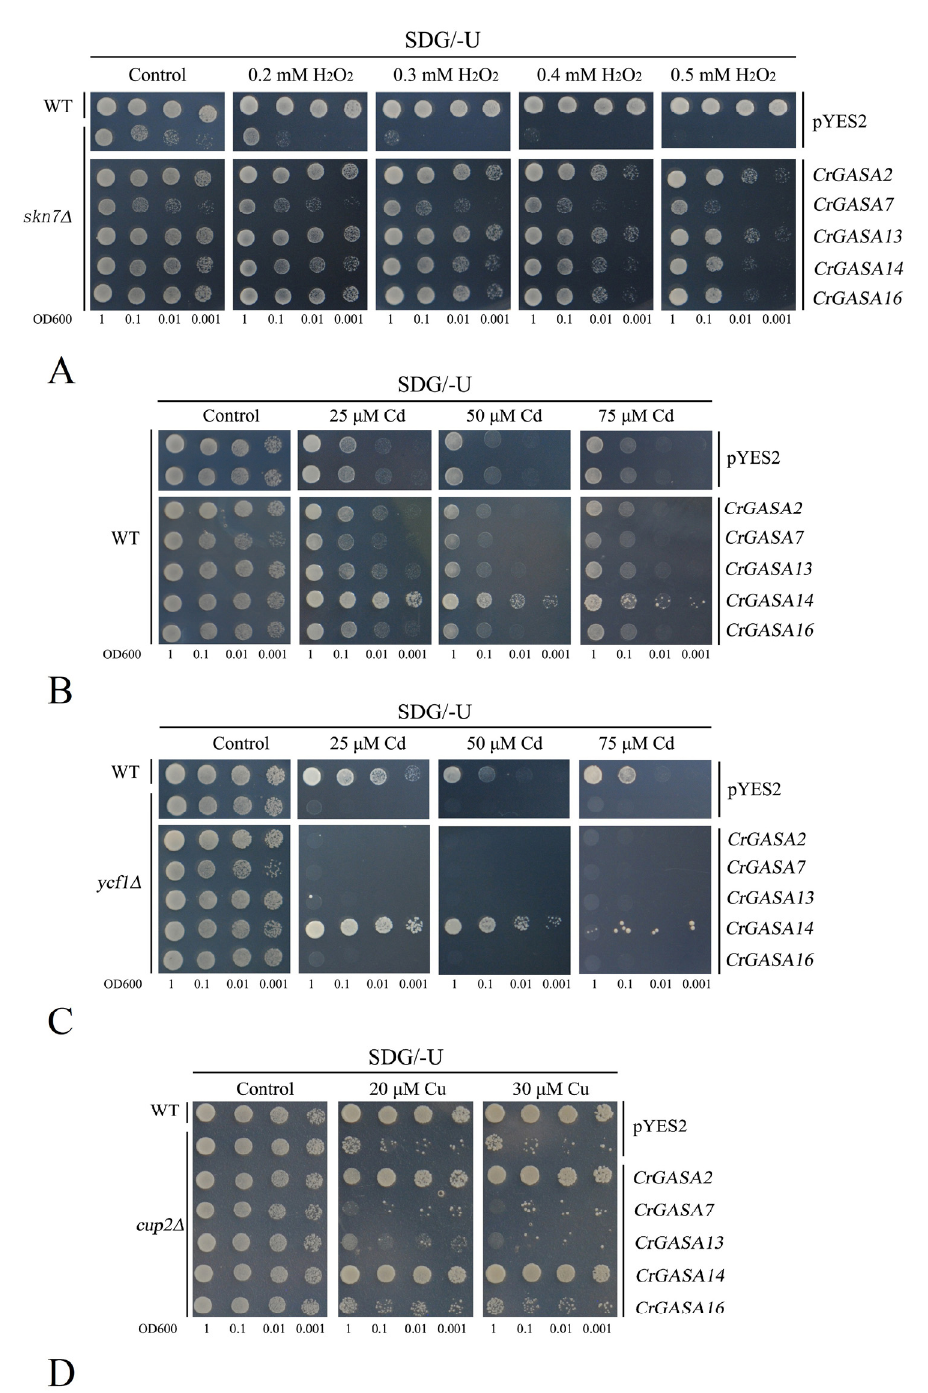
Figure 11. Functional identification of five CrGASA s in yeast by heterologous expression assay. The yeast wild-type (WT) strain BY4741, and yeast mutant strains skn7 ∆ (sensitive to H 2 O 2 ), ycf1 ∆ (sensitive to cadmium), and cup2 ∆ (sensitive to copper), were transformed with the empty vector pYES2 and five recombinant vectors, including CrGASA2-pYES2, CrGASA7-pYES2, CrGASA13-pYES2, CrGASA14-pYES2, and CrGASA16-pYES2. Yeast cultures were adjusted to OD600 = 1, and 2 µ L serial dilutions (10-fold, from left to right in each panel) were spotted on SDG-Ura medium supplemented with different concentrations of stressors. ( A ) H 2 O 2 oxidative stress tolerance confirmation in yeast mutant strain skn7 ∆ ; ( B ) cadmium tolerance confirmation in WT yeast; ( C ) cadmium tolerance confirmation in mutant yeast strain ycf1 ∆ ; ( D ) copper tolerance confirmation in mutant yeast strain cup2 ∆ .